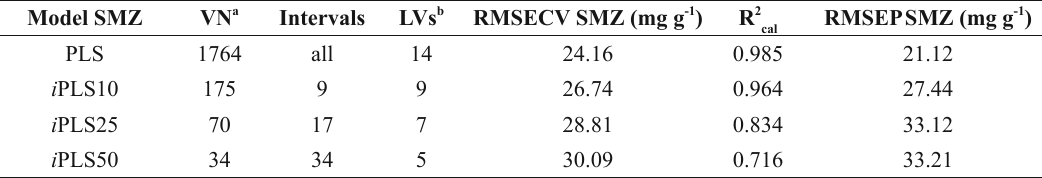
Statistical results to i PLS calibration models and full-spectrum PLS model without pretreatment for the SMZ.